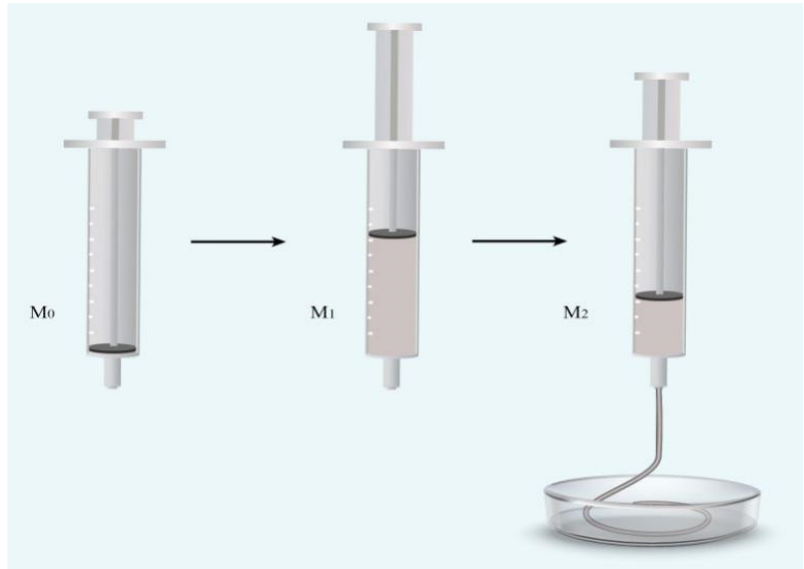
Figure 2. Measurement of injectability.